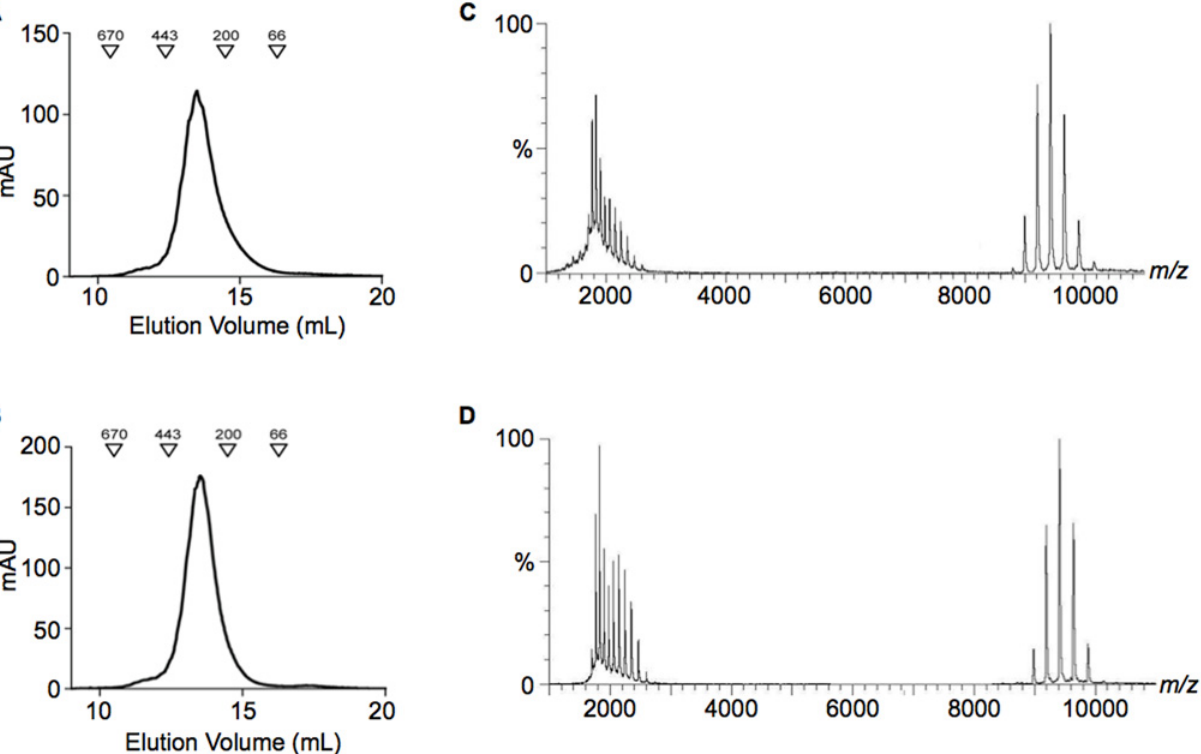
Fig 6. Size-exclusion chromatography and mass spectrometry analysis of wild-type SEN and SEN K312A . Size-exclusion chromatography elution profile of ( A ) wild-type SEN and ( B ) SEN K312A shows that both proteins elute as a single mono-disperse peak. Molecular weight standards are indicated by triangles. Subsequent mass spectra of ( C ) wild-type SEN and ( D ) SEN K312A illustrate that both proteins exist as